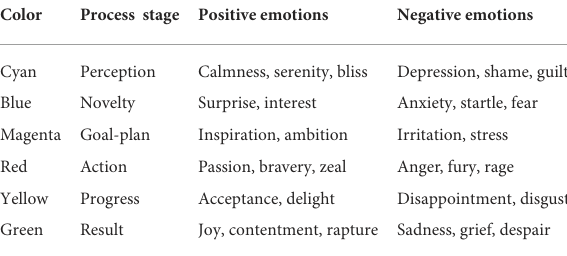
TABLE 2 Correspondence of colors, process-semantic classes, and emotional experiences.